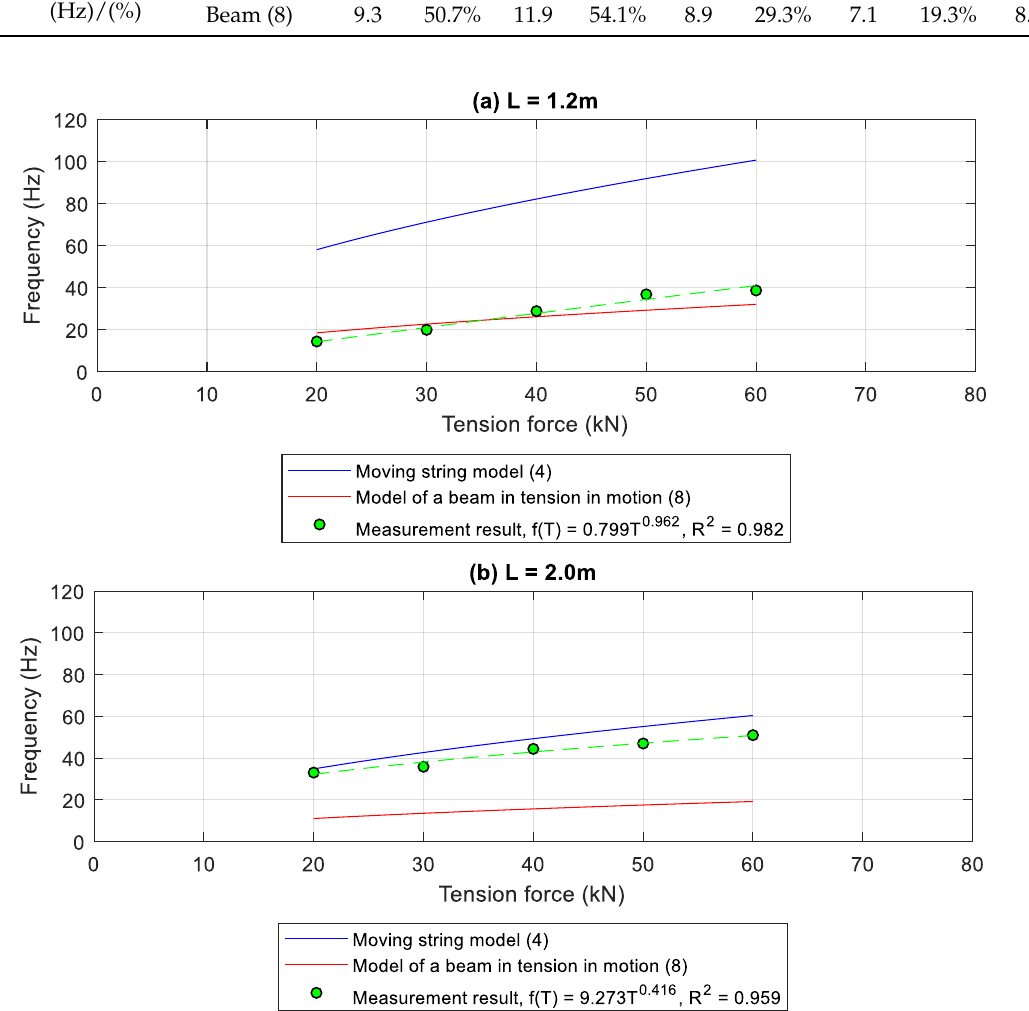
Figure 6. Comparison of the measured frequencies of belt transverse vibrations with the theoretical models as a function of belt tensile force for the belt speed of 2.4 m/s: ( a ) idler spacing L = 1.2 m; ( b ) idler spacing L = 2.0 m. Table 2. Differences between the theoretical models and the mean measurement results for the belt speed of 2.4 m/s. Idler Spac-